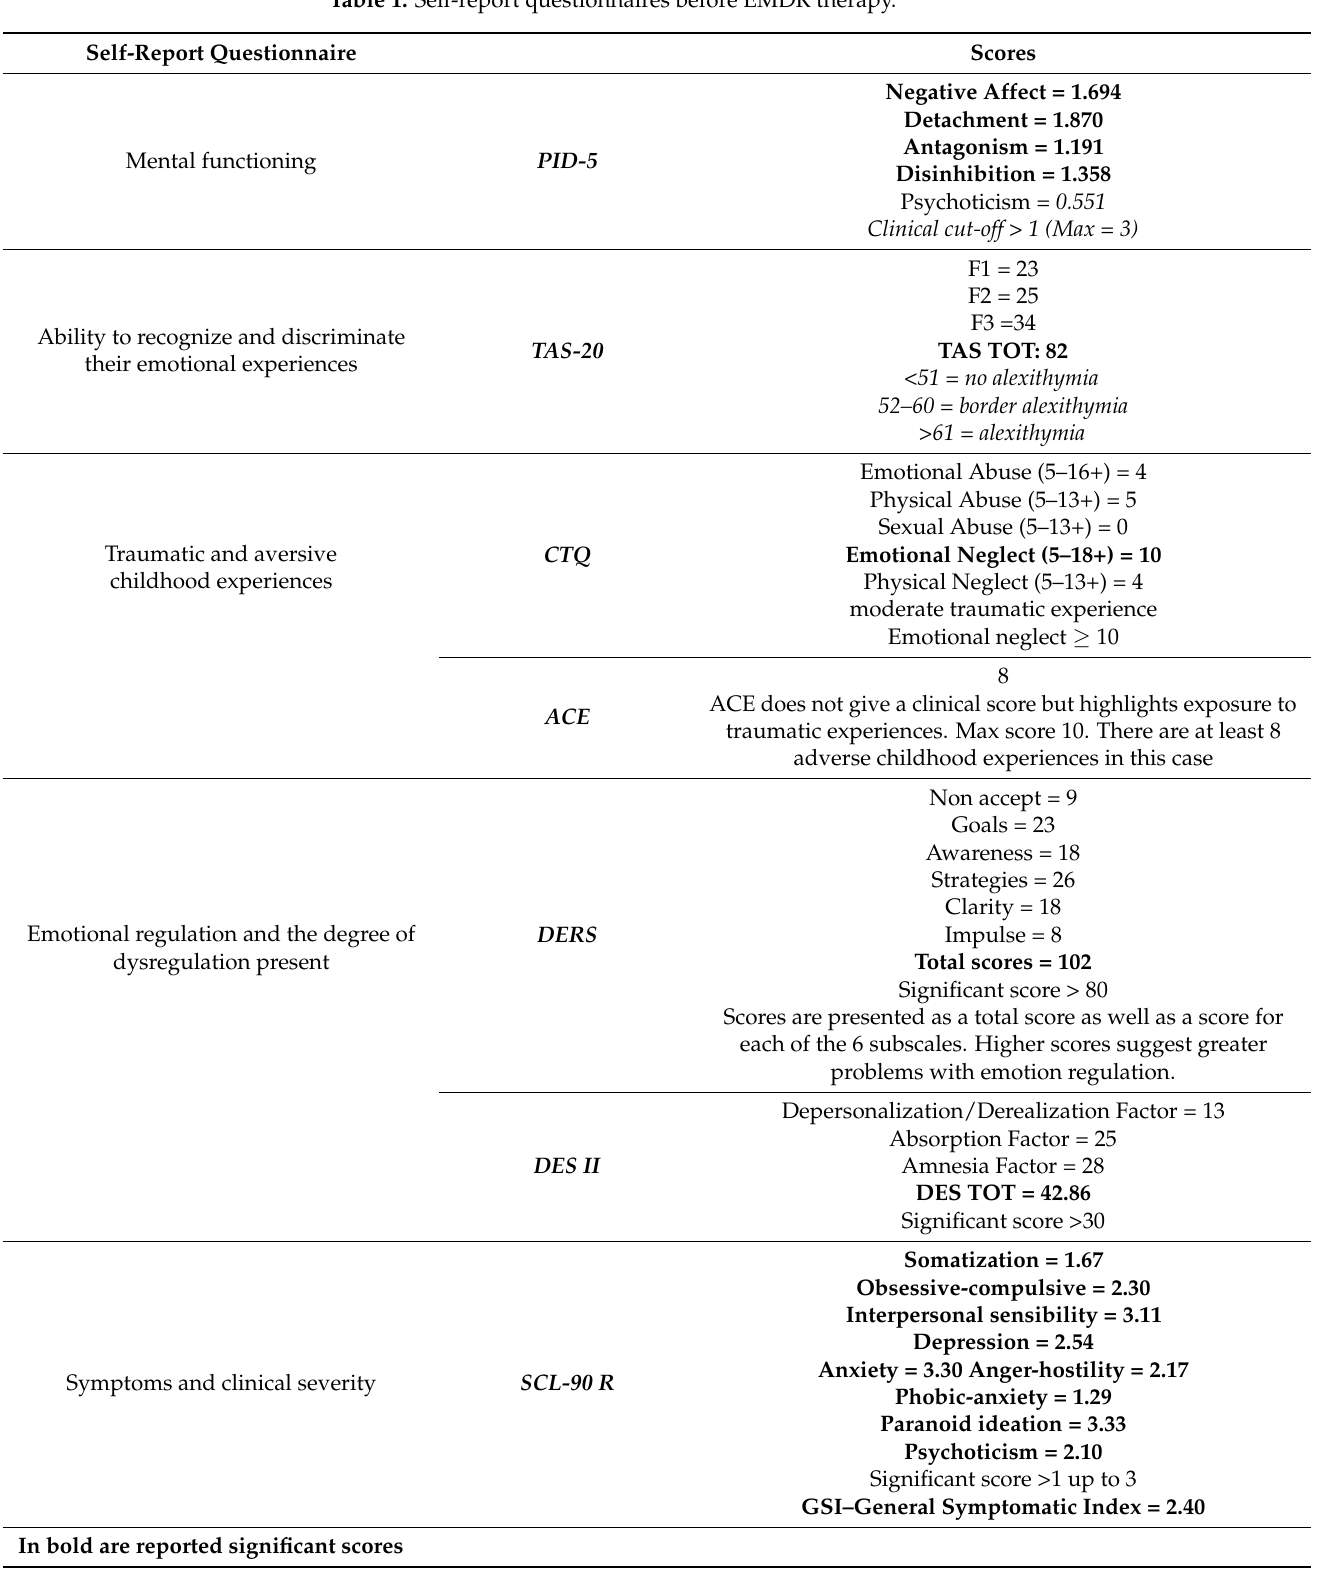
Table 1. Self-report questionnaires before EMDR